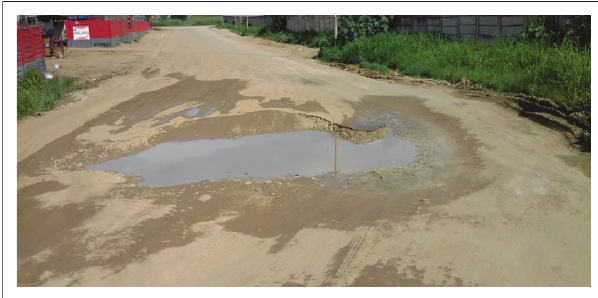
Source : Photograph taken by Peter Bikam, at Louis Trichardt, in 2014, used with permission from Peter Bikam. FIGURE 2: A typical road conditions in Louis Trichardt,